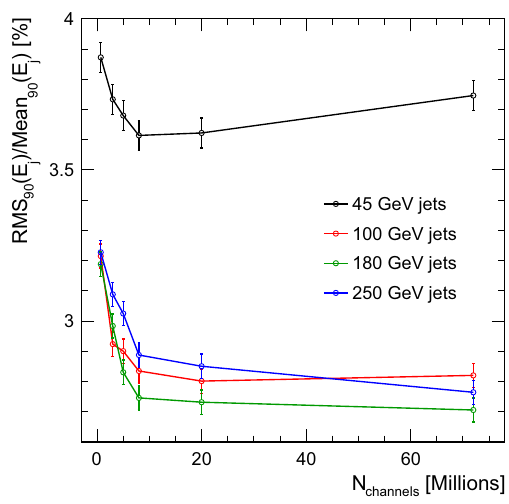
Fig. 12 Jetenergyresolutionwithsoftwarecompensationasafunction of number of channels in the HCAL for different jet energies